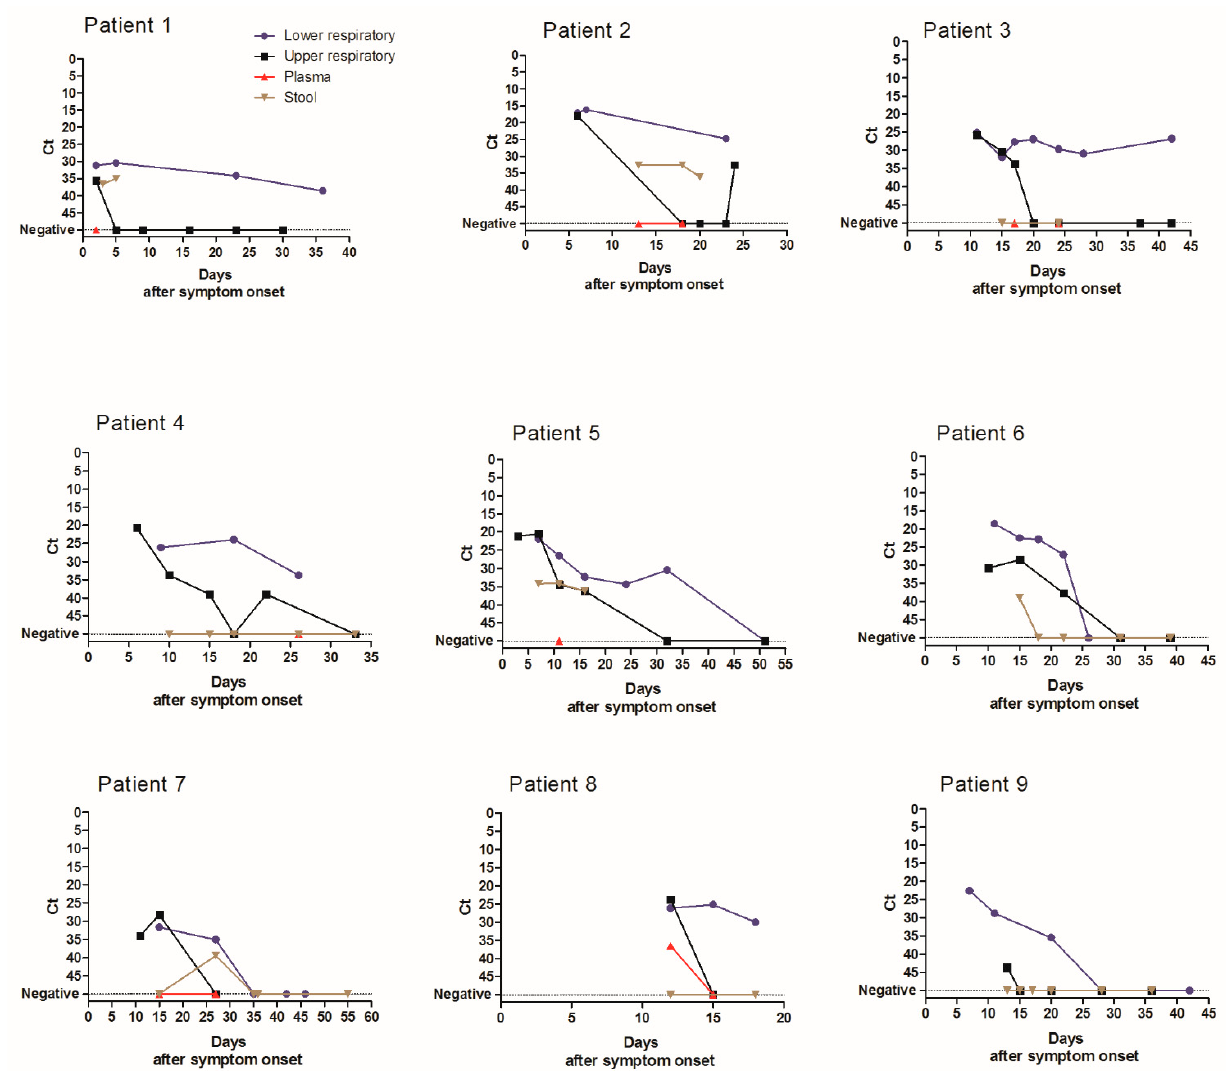
Figure 4. Spatio-temporal SARS-CoV-2 virus load kinetics in individual